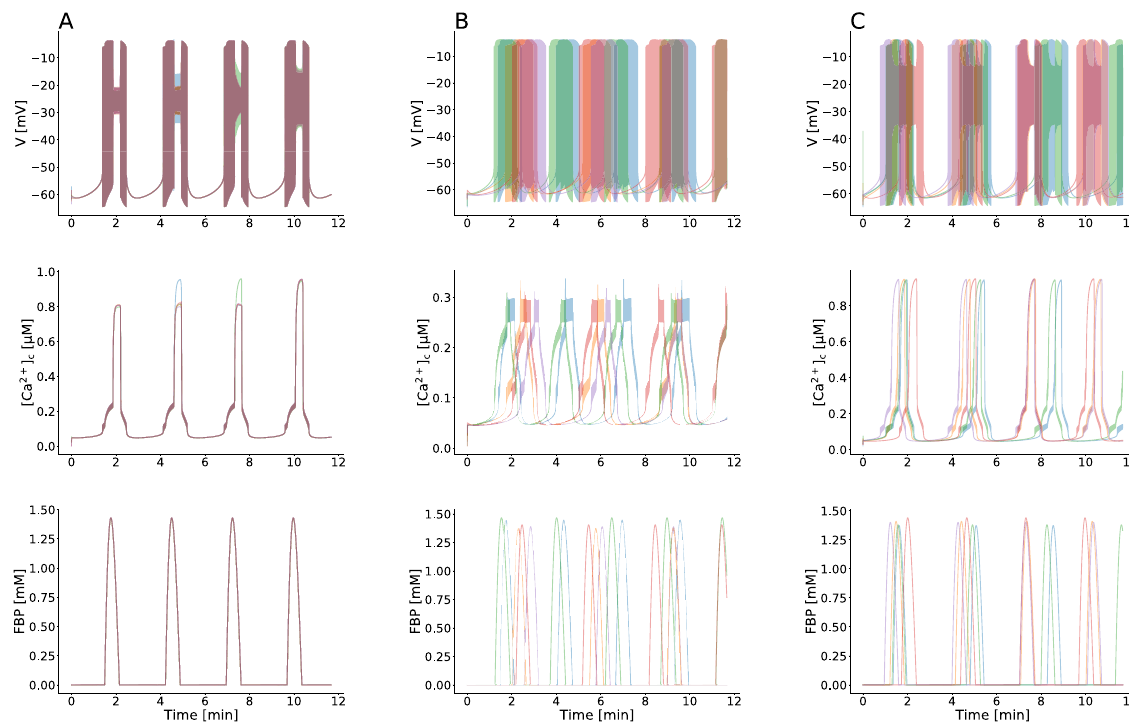
Figure 5. Effect of Kv-channels on [ Ca 2 + ] c patterns. ( A ) Membrane potential, cytosolic calcium, and FBP time series for coupled human β -cells with g Kv = 0.215 nS pF − 1 . ( B ) As in panel ( A ), but for uncoupled β -cells. ( C ) Model simulation of uncoupled β -cells as in panel ( B ), but with g Kv = 0.200 nS pF − 1